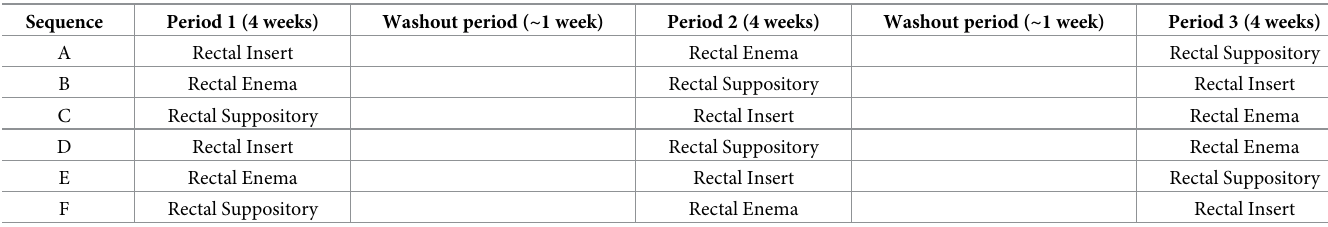
Table 1. Randomization sequence